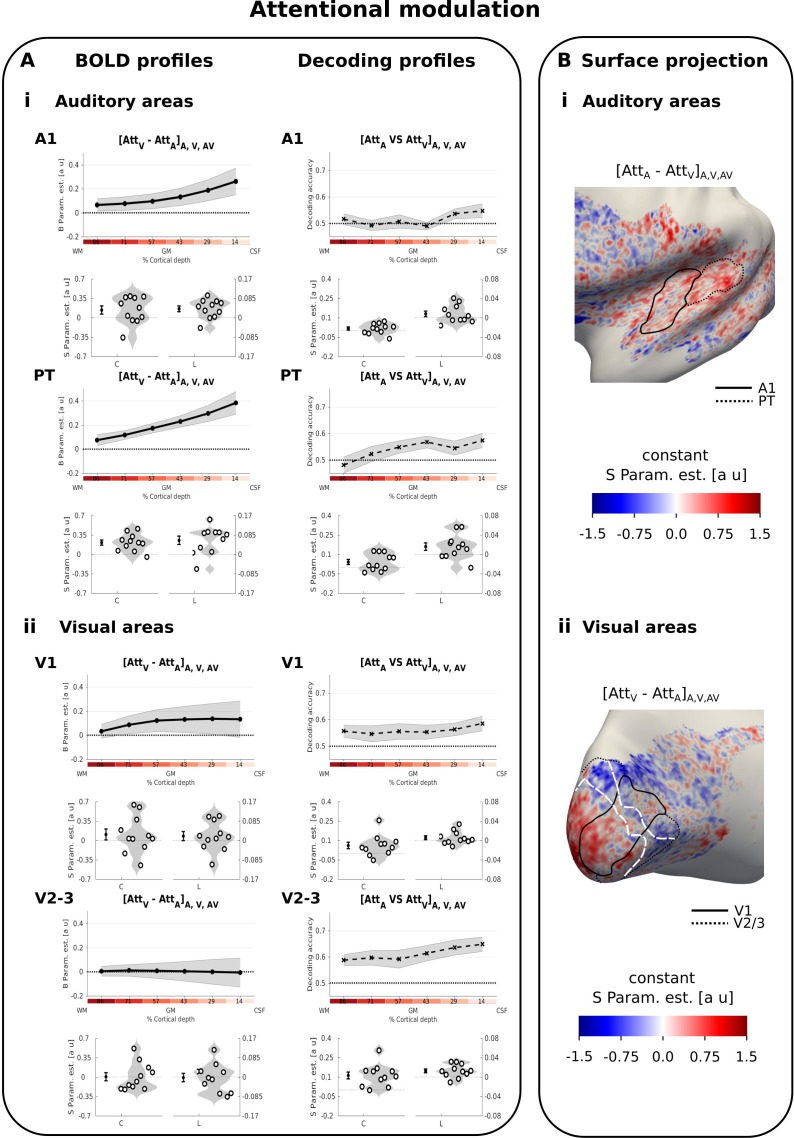
Attentional modulation.(A) Laminar profiles: Rows 1, 3, 5, 7: The BOLD response (solid line; columns 1 and 3) and decoding accuracy (dashed line; columns 2 and 4) (across subjects’ mean ± SEM) for attentional modulation (i: top - [AttA-AttV] in A1 and PT; ii: bottom - [AttV-AttA] in V1 and V2/3) is shown as a function of percentage cortical depth pooled (i.e. averaged) over auditory, visual and audiovisual looming stimuli. WM: white matter, GM: grey matter, CSF: cerebrospinal fluid. Percentage cortical depth is indicated by the small numbers and colour coded in red. Rows 2, 4, 6, 8: Across subjects’ mean (± SEM) and violin plot of the participants’ shape parameter estimates that characterize the mean (C: constant) and linear increase (L: linear) of the laminar BOLD response and decoding accuracy profiles. n = 11. B. Surface projections: Across subject’ mean of the ‘constant’ shape parameter estimates for attentional modulation [AttA-AttV]A,V, AV in A1 and PT (i: top) and in V1 and V2/3 (ii: bottom) are projected on an inflated group mean surface of the left hemisphere. A1 and V1 are delineated by black solid lines. PT and V2/3 are delineated by dashed lines. For visualization purposes only: i. surface projections were smoothed (FWHM = 1.5 mm); ii. values are also presented for vertices for which data were not available from all subjects and which were therefore not included in our formal statistical analysis; iii borders between visual-induced activations and deactivations (white dashed lines on the right) are reported here from Figure 2B. Grey areas denote vertices with no available data for any subject.